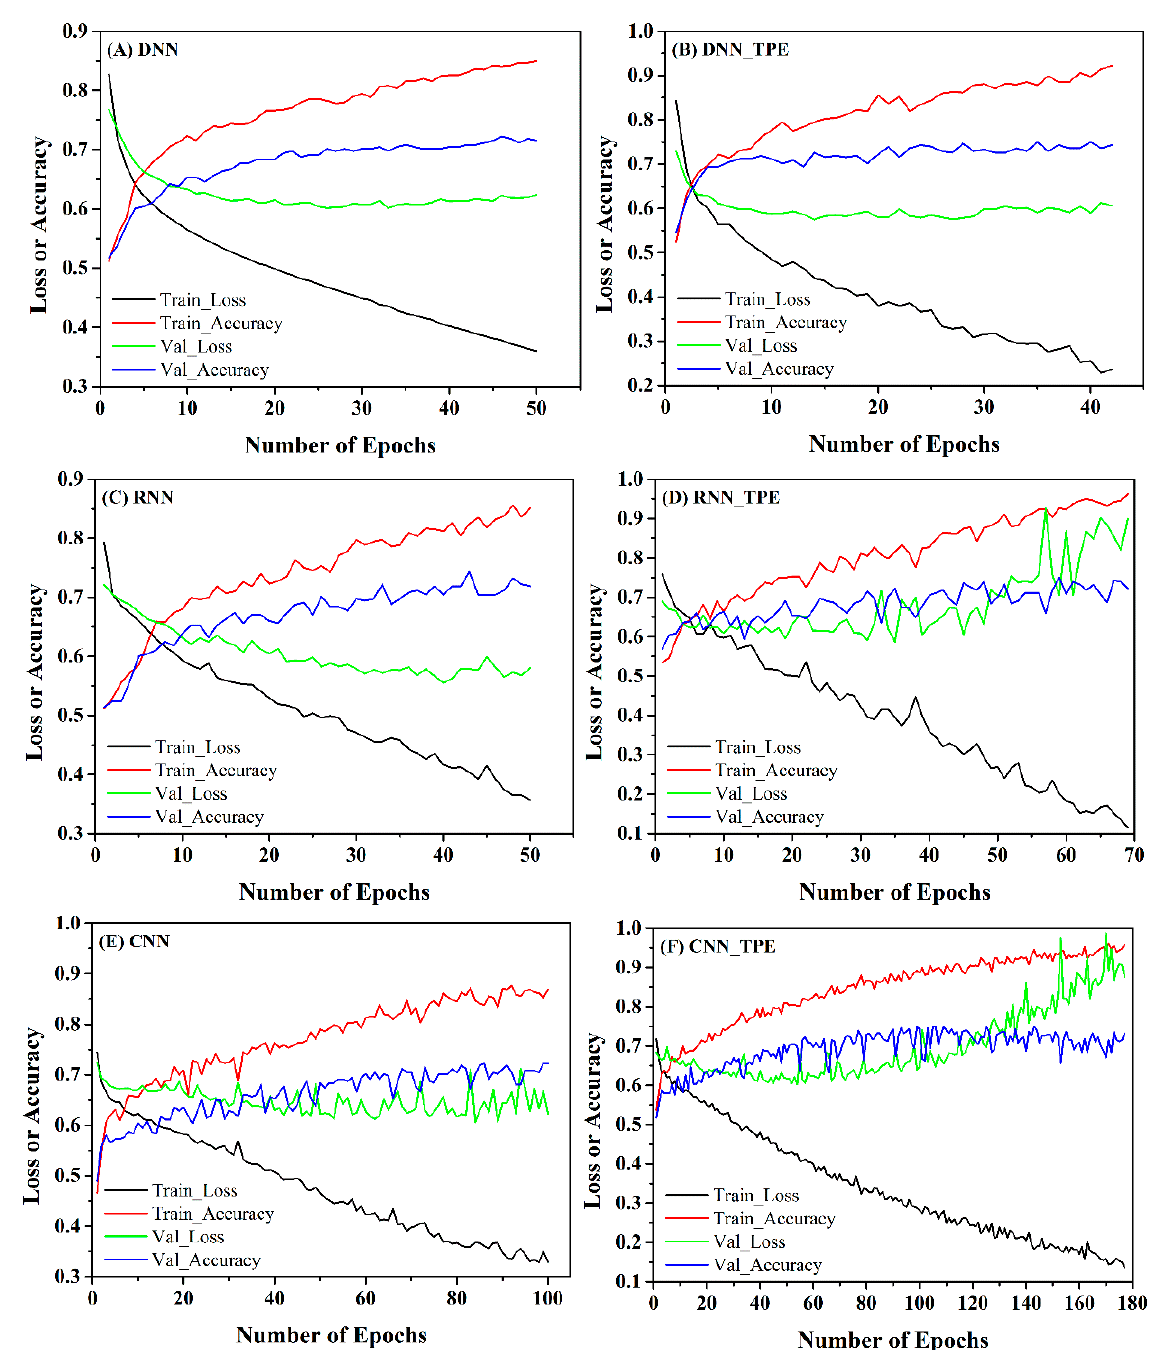
Figure 14. The loss and accuracy of the training and validation sets during the epochs of each model: ( A ) DNN, ( B ) DNN_TPE, ( C ) RNN, ( D ) RNN_TPE, ( E ) CNN, and ( F ) CNN_TPE.